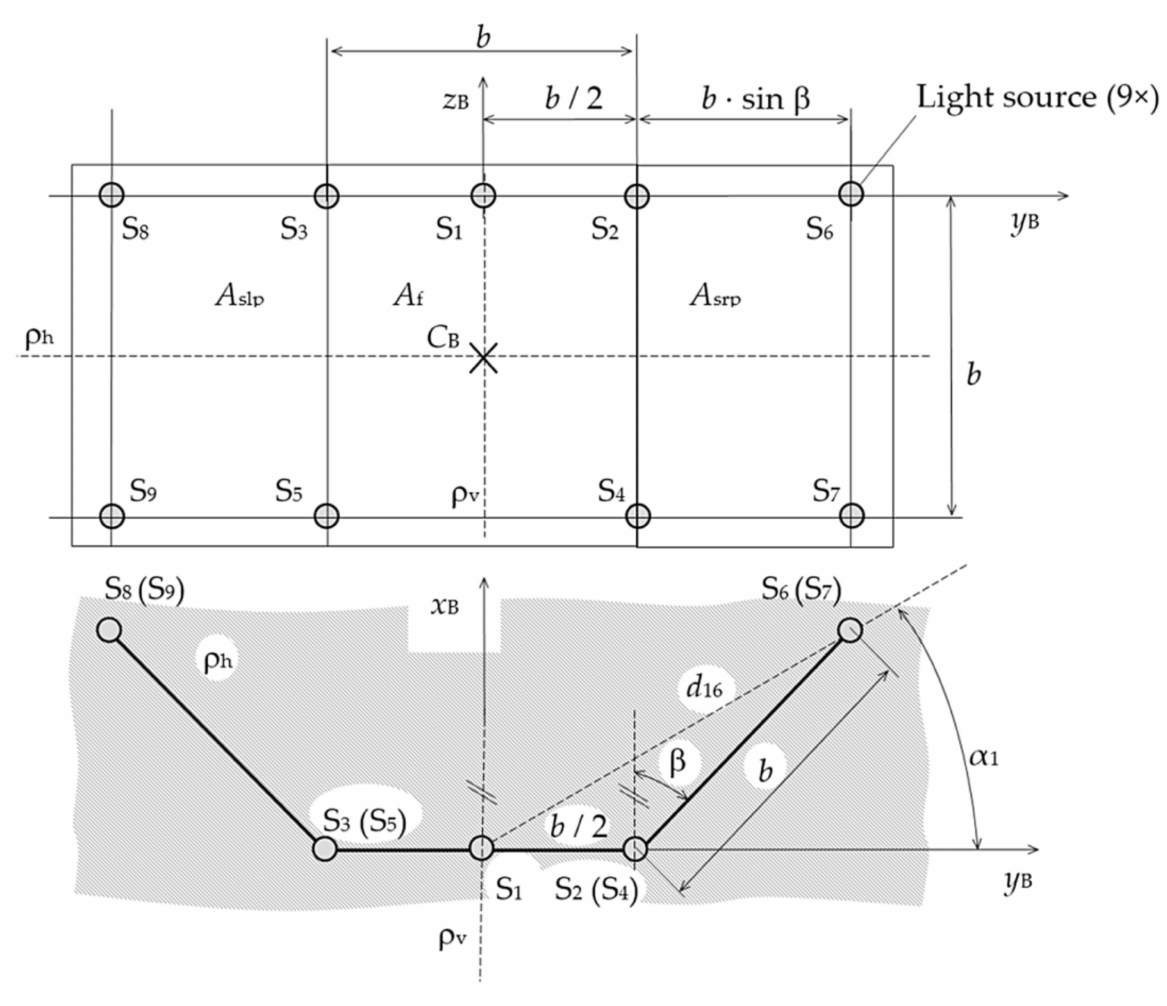
Figure 1. Beacon layout